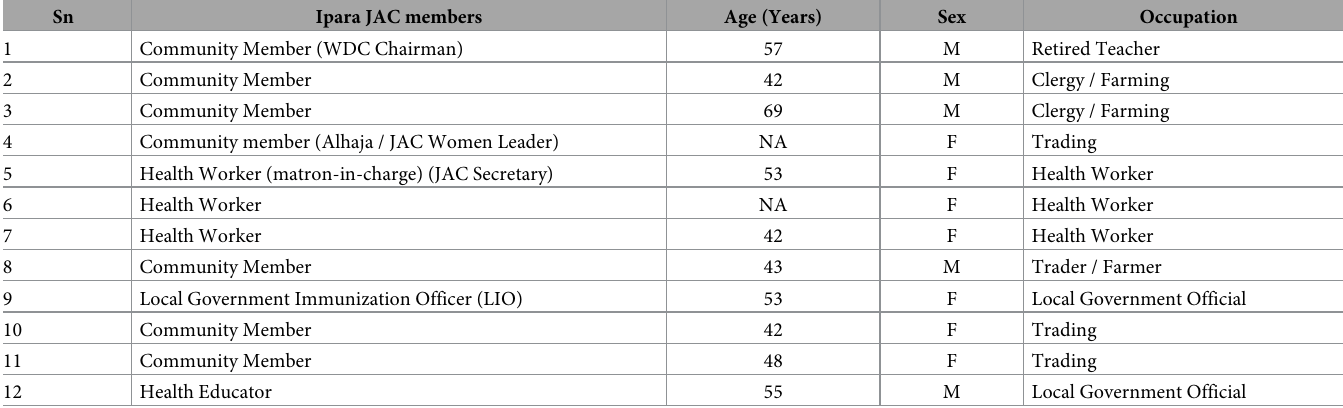
Table 3. Ipara JAC members.